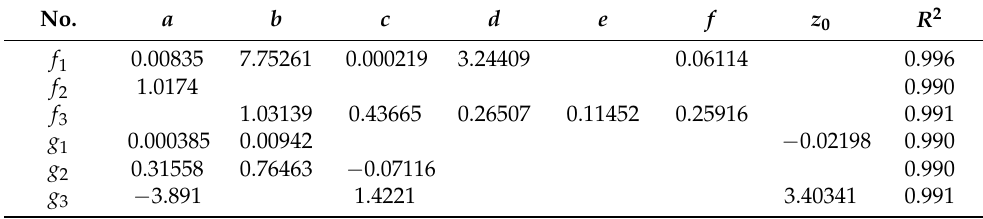
Table 2. Summary of fitting coefficients.